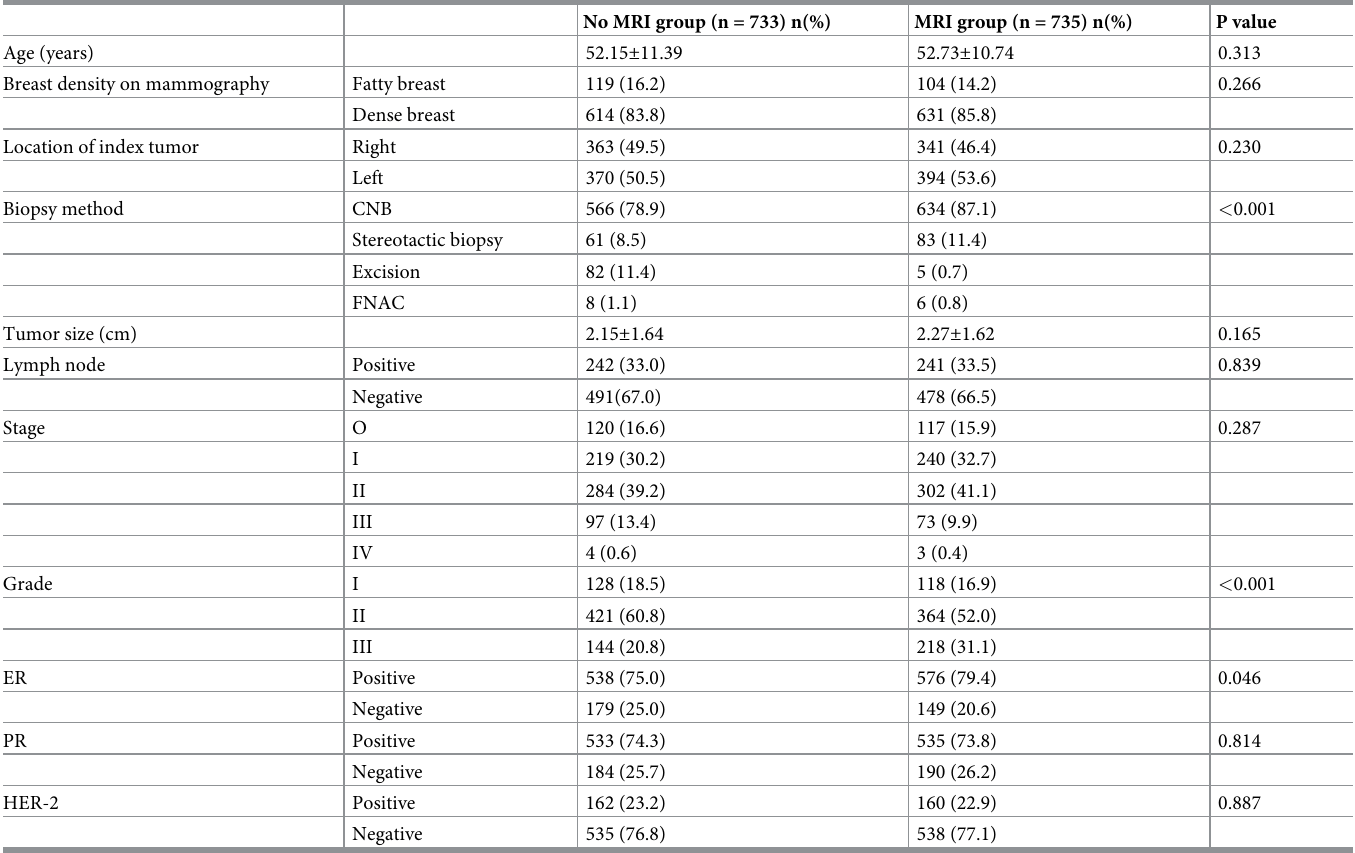
Table 1. Clinicopathologic characteristics of patients and tumors in current case control comparison study.